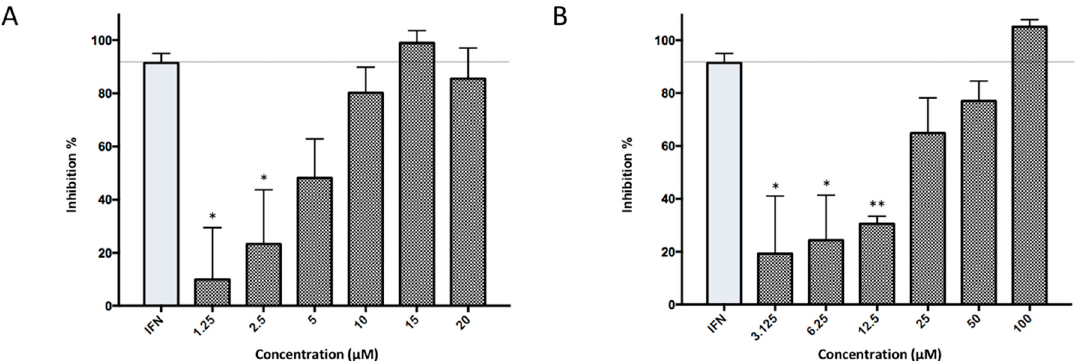
Figure 3. Dose-dependent inhibitory activities of Compounds 1 and 2 . ( A ) Inhibitory activities of Compound 1 under a gradient concentration from 1.25 μ M to 20 μ M against ZIKV infection on BHK-21 cell lines. ( B ) Inhibitory activities of Compound 2 under a gradient concentration from 3.125 μ M to 100 μ M against ZIKV infection on BHK-21 cell lines.